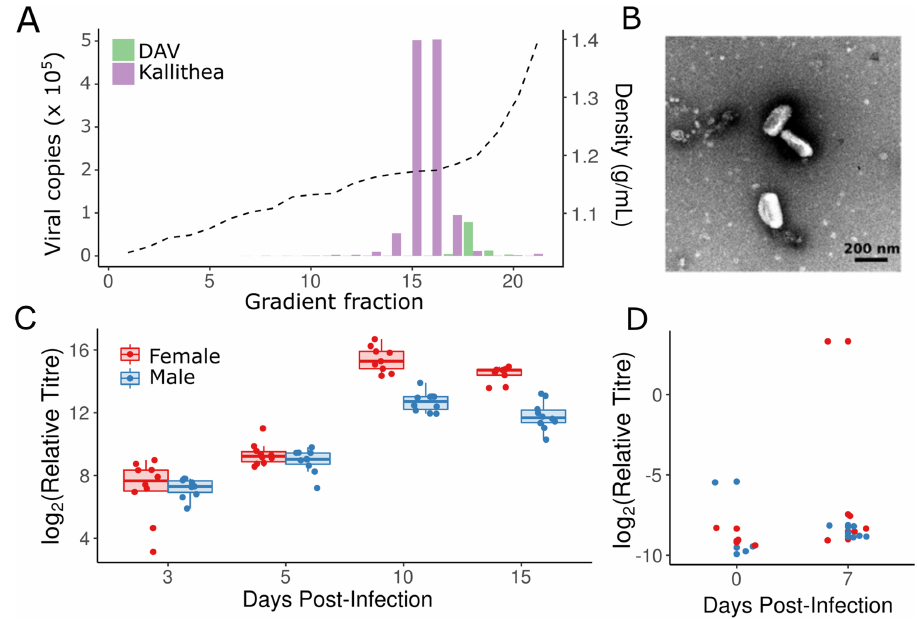
Fig 1. Isolation of KV and growth in flies. (A) Density gradient and virus titre: Kallithea virus (purple) was effectively separated from DAV (green) at 1.18 g/mL (dotted line) in fractions 15 and 16 of an iodixanol gradient. (B) Transmission electron micrograph of KV-positive fractions showed KV to be a rod-shaped enveloped particle, as has been described previously for other nudiviruses [55]. We did not observe unenveloped KV particles, bacteria, or RNA viruses in the isolate. (C) Relative viral titres normalised by the number of fly genomic copies and virus levels at time zero in each sex. Each point represents a vial of 10 flies. Viral titres peaked at 10 days post-infection, and were generally higher in females (red) than males (blue) late in infection. (D) We were able to infect adult flies orally by applying the viral isolate to Drosophila medium, although relative copy number of the virus was very low and infection was inefficient, with only 2 of 16 vials (each of 10 flies) having increased titre after one week, indicating an infectious rate lower bound of ~1% at 5x10 3 ID50.